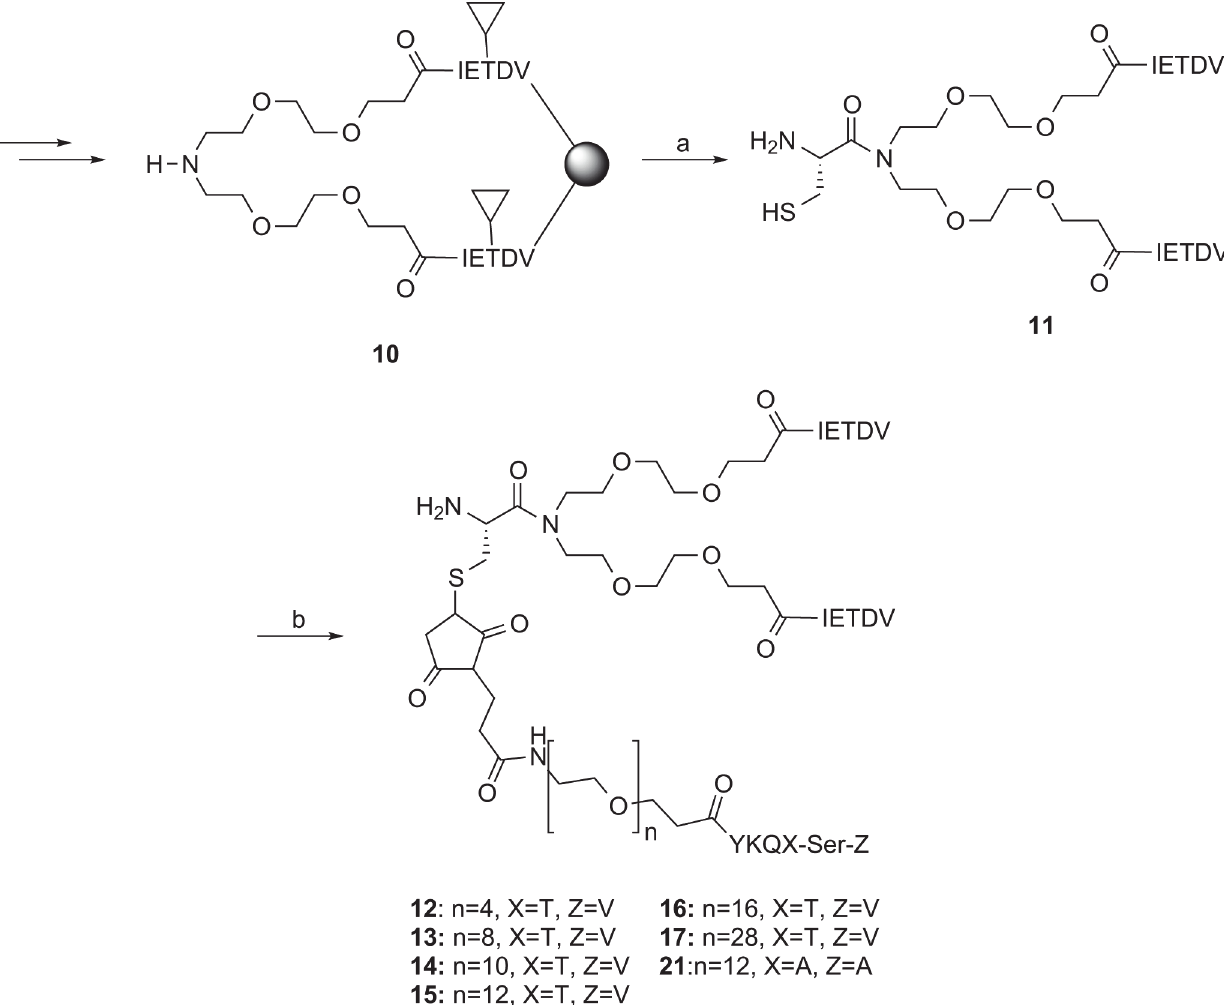
Fig 3. Synthesis of building blocks 10 – 17 and 21. Reaction conditions: (a) 1. Fmoc-Cys(Trt)-OH, HATU, collidine, DMF (2x45 min), 2. 20% Piperidine in DMF, 3. TFA,TIPS, EDT,